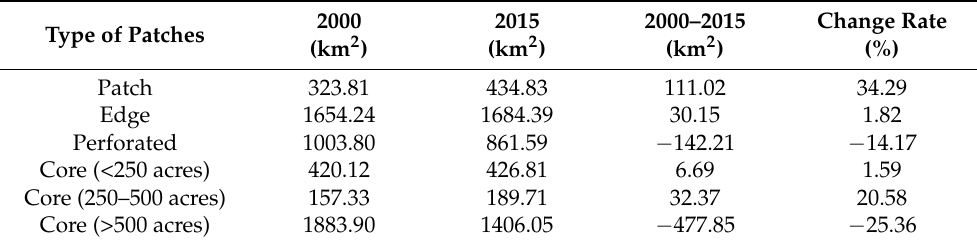
Table 5. Forest fragmentation and change in KSL between 2000 and